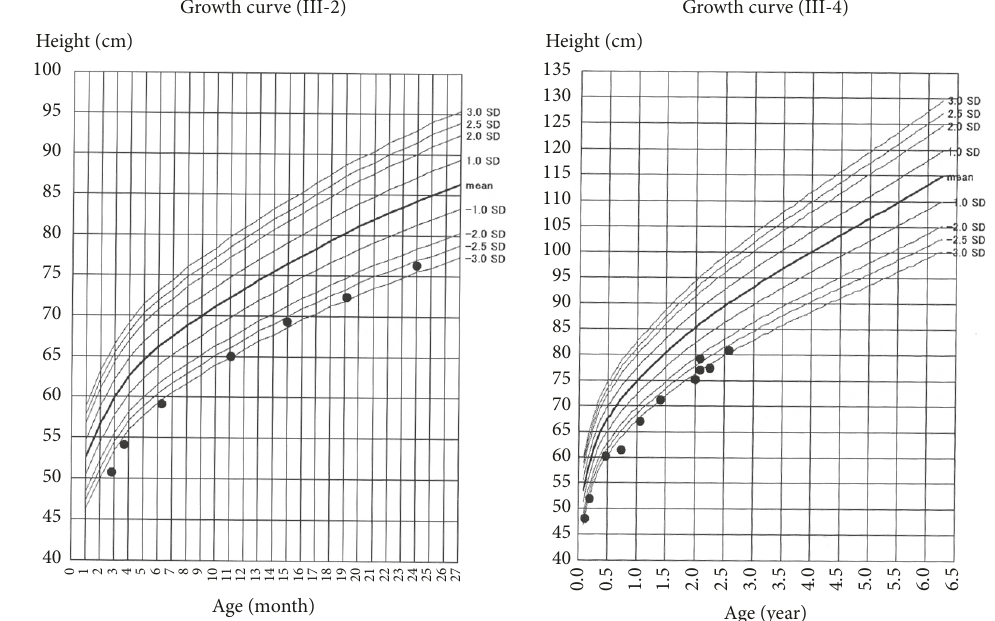
Figure 3: Growth curve of first (III-2) and second (III-4) infants suggested postnatal growth failure.